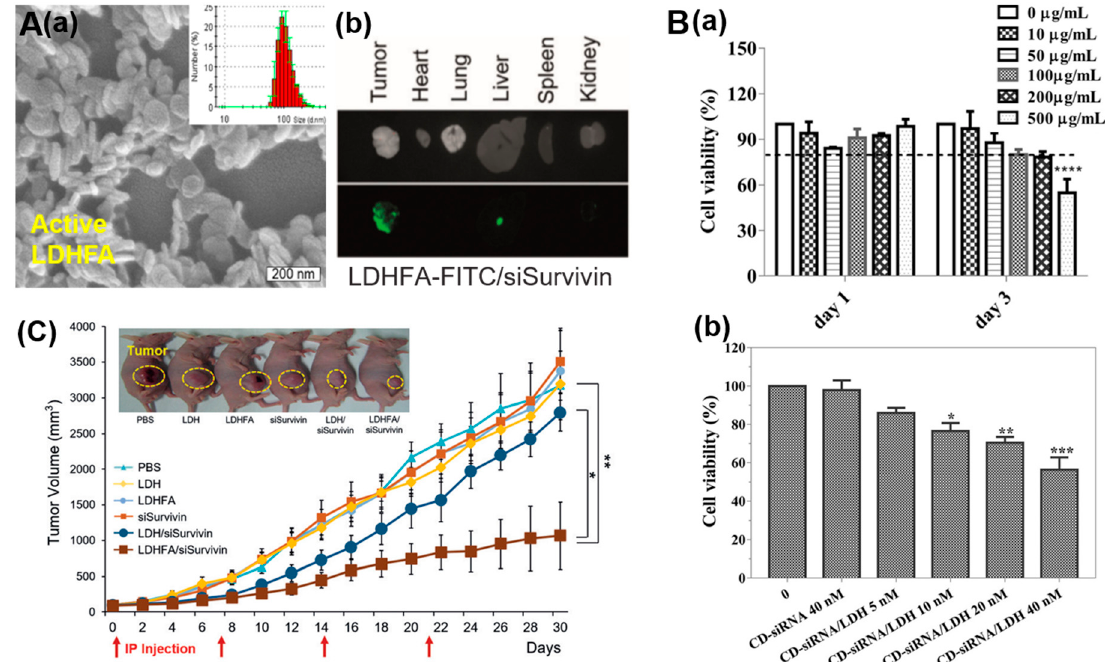
Figure 4. ( A ) ( a ) SEM image and size distributions (inset) of active LDHFA, ( b ) ex vivo biodistribution of the FITC-LDHFA-siSurvivin in the xenograft model: Optic (top) and fluorescence (bottom) images, ( c ) in vivo anti-tumor e ffi cacy of KB tumor-bearing mice treated for 30 days via intraperitoneal injection once every 7 days (inset photo image shows the mice on 18 days post-treatment), reproduced from [8]. ( B ) MTT assay of the viability of N2a cells treated ( a ) with Mn-LDH at concentrations from 0 to 500 µ g / mL, ( b ) with free CD-siRNA and CD-siRNA / LDHs. The siRNA:LDH mass ratio was 1:40, reproduced from reference [18].